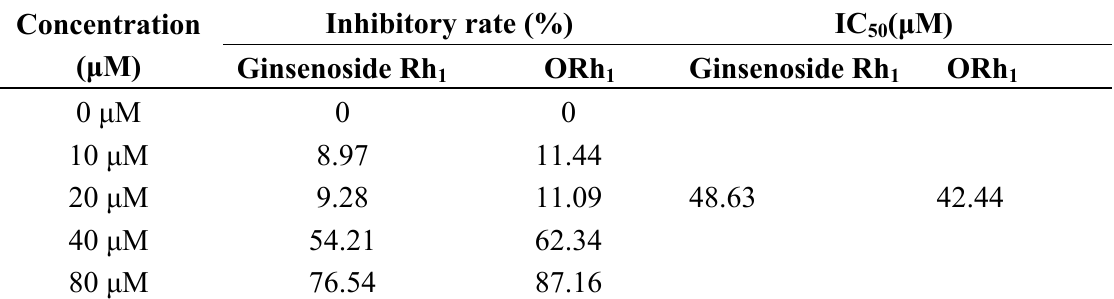
Table 3. Anti-tumor activities of compound 3 and 4 (IC 50 values in μ M).